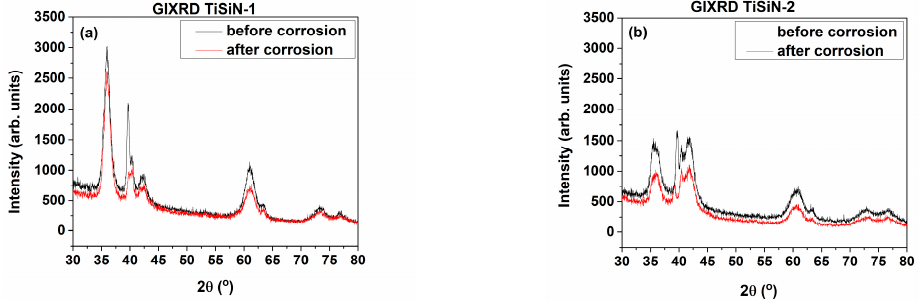
Figure 2. Comparison of GIXRD spectra before and after corrosion for: ( a ) TiSiCN-1 and ( b ) TiSiCN-2.